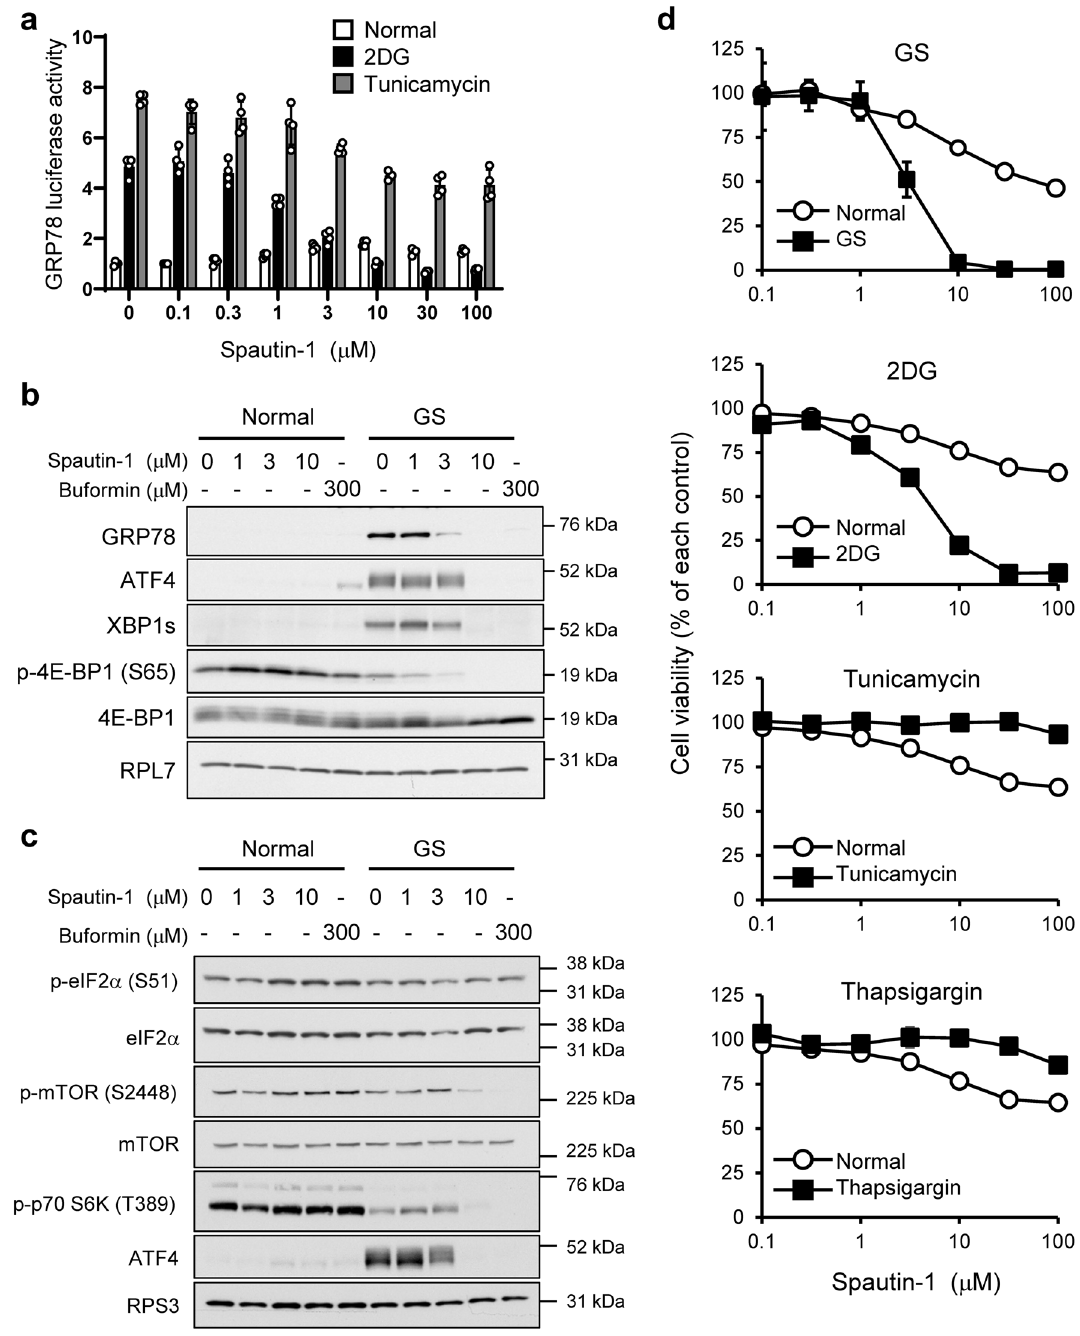
Figure 1. Spautin-1 inhibits the UPR and cell survival in glucose-starved and 2DG-stressed HT1080 cells. ( a ) HT1080 cells were transfected with the pGRP78pro160-Luc plasmid and then treated with spautin-1 in the presence of ER stressors (2DG: 10 mM, tunicamycin: 10 μg/mL) for 18 h. Luciferase activity was determined by a dual-luciferase reporter assay system. Data are shown as mean ± SD ( n = 4). ( b , c ) HT1080 cells were treated with spautin-1 or buformin under control or GS conditions for 18 h, followed by western blot analysis for the indicated proteins. RPL7 and RPS3 were used as loading controls. The blot membranes were cut prior to hybridization with antibodies, according to Full range rainbow molecular weight markers. Original blots were presented in Supplementary Fig. S5. ( d ) HT1080 cells were treated with spautin-1 in the presence of ER stressors (2DG: 10 mM, tunicamycin: 10 μg/mL, thapsigargin: 300 nM) for 48 h. Cell viability was determined by the CellTiter-Glo luminescent cell viability assay. Data are shown as mean ± SD ( n =